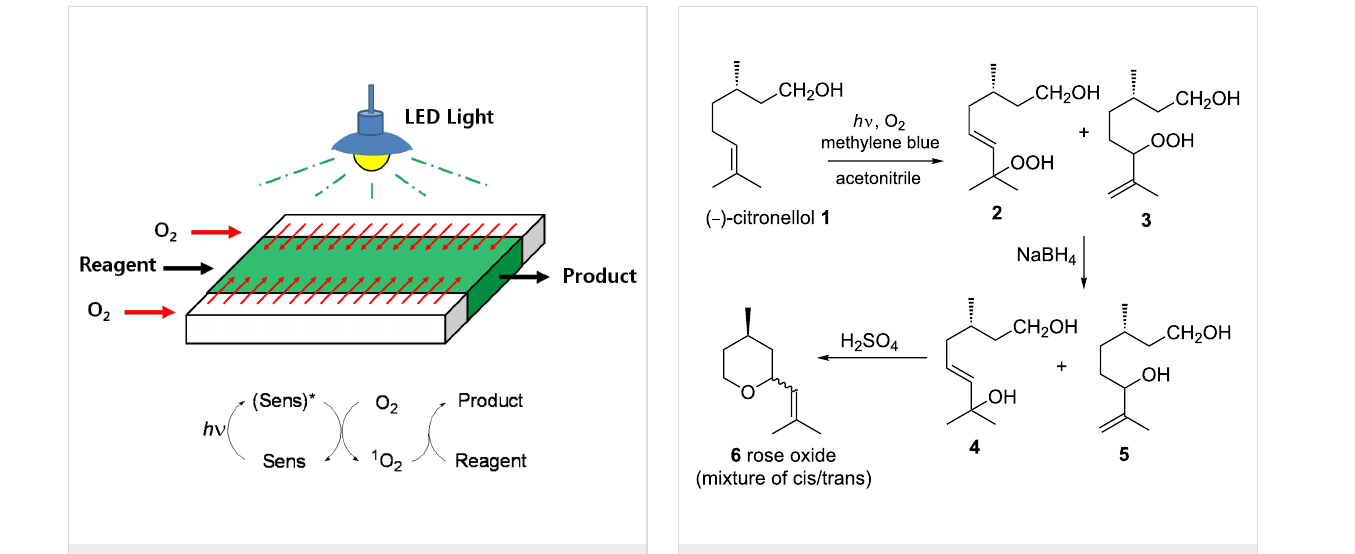
Table 1 represents the technical data for a typical batch reactor (50 mL round bottom flask), dual channel and triple